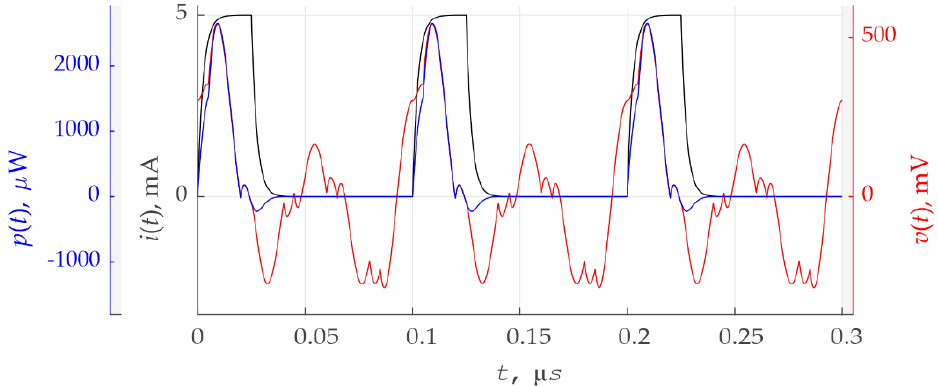
Figure 15. The current, voltage and power for the case of transmission line and pulse train current.